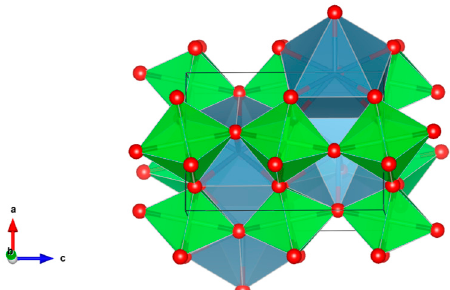
Figure 6. Perovskite. CaTiO 3 , Structure cubic, Sp. gr. Pm3m. Cations can be Ca, Y, REE, Ti, Zr, U and Pu.